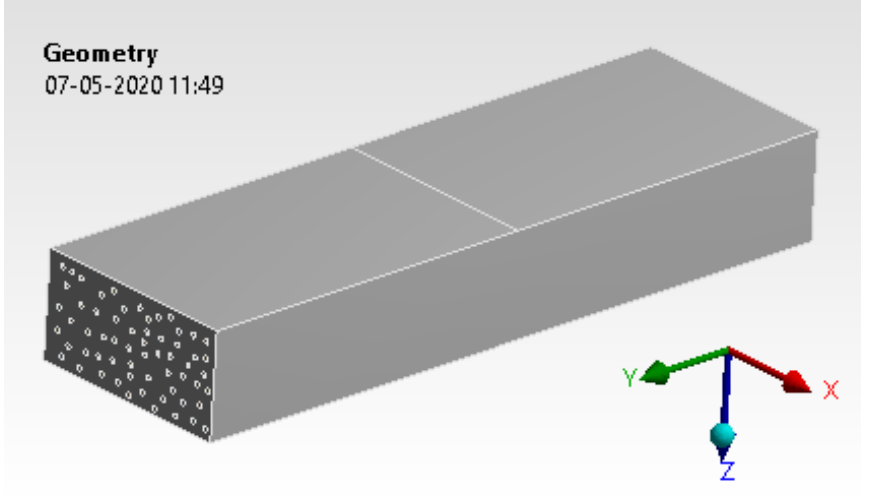
Figure 10. Concrete and lead oxide.